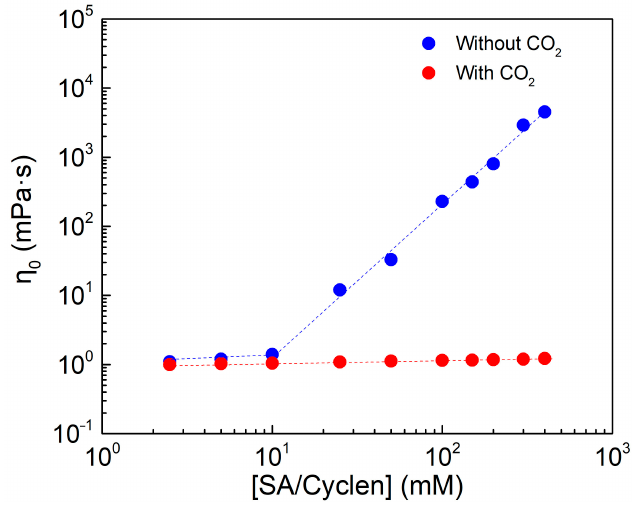
Figure 7. The effect of concentration on viscosity of SA/cyclen solution without and with CO 2 at 25 °C, the shear rate is 10 s − 1 .